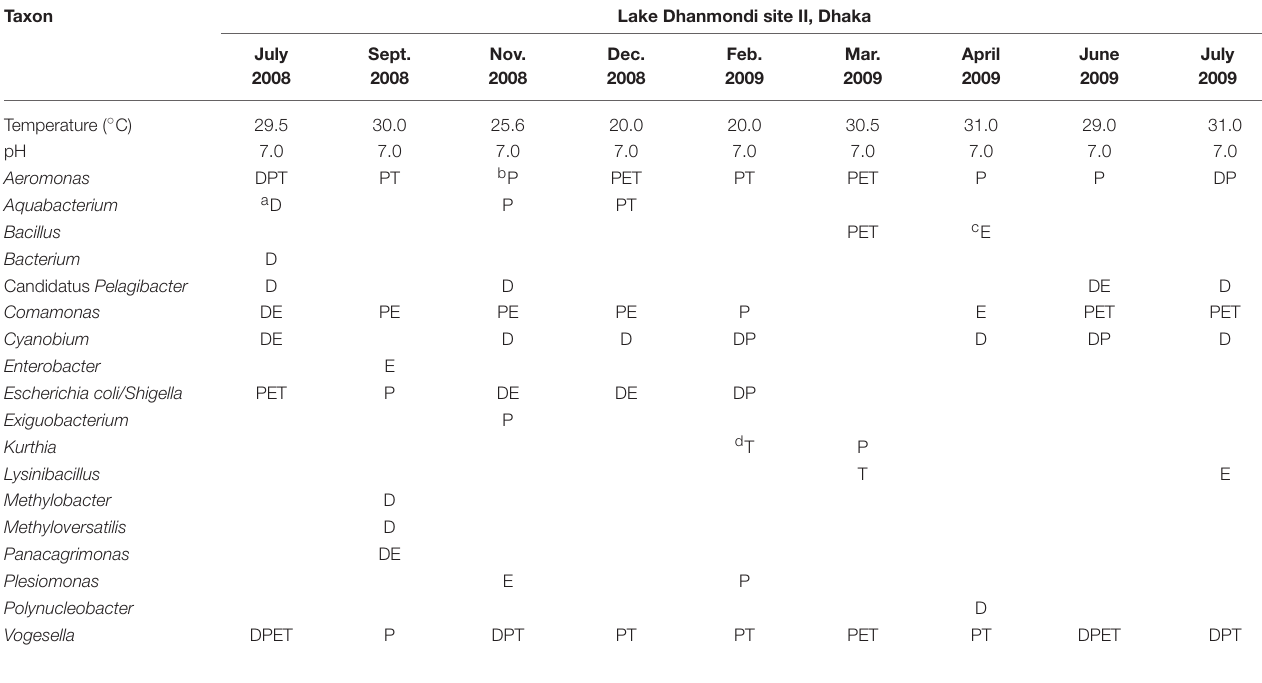
TABLE 3 | Distribution of bacterial genera in Lake Dhanmondi site II in July 2008–2009.